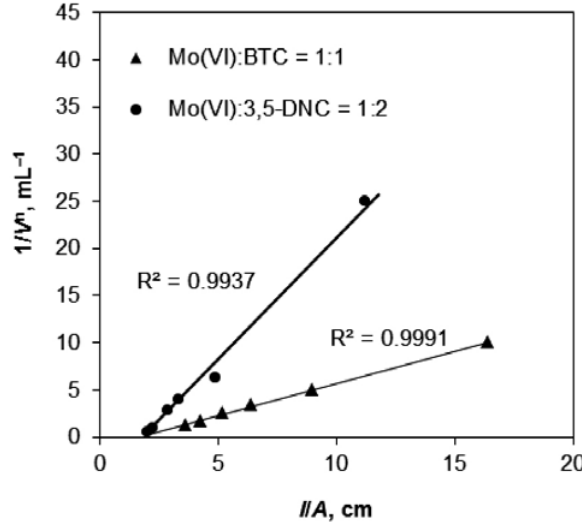
Figure 2. Determination of the molar ratio (n) by the method of As- mus C = 3.12 × 10 –5 mol L –1 ; C = 4.0 × 10 –1 mol L –1 ; λ = Mo(VI) H2SO4 405 nm; τ = 1 min (cid:2) Mo(VI):3,5-DNC, C